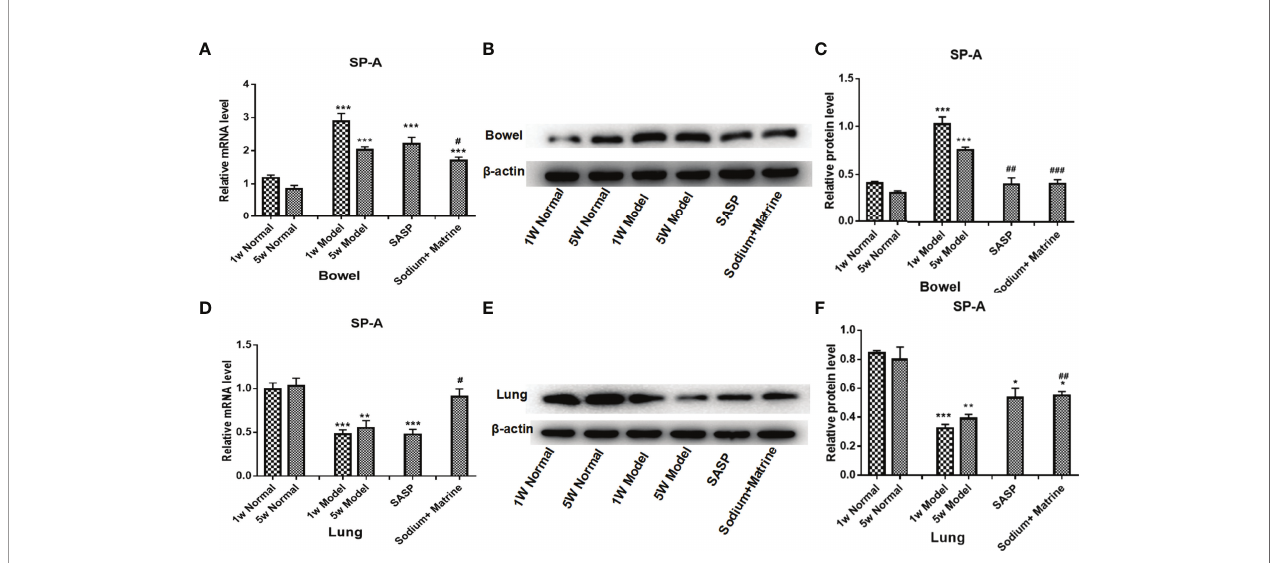
FIGURE 6 | Changes of SP-A in the lung and the bowel. UC models were established with the mucous membrane of colon allergize combine with TNBS-alcohol enteroclysis. (A) SP-A mRNA expression in the bowel (PCR); (B) SP-A protein expression in the bowel (Western Blotting); (C) SP-A relative protein level in the bowel; (D) SP-A mRNA expression in the lung (PCR); (E) SP-A protein expression in the lung (Western Blotting); (F) SP-A relative protein level in lung. Compared with Normal group, *P < 0.05; **P < 0.01; ***P < 0.001. Compared with model group, # P < 0.05, ## P < 0.01, ### P < ( Figure 7B ). After 5 w of drug administration, the blood urea nitrogen in the SASP group was signi fi cantly lower than that of the model group (P < 0.05); however, no signi fi cant difference was observed among the other groups. Negligible deviation occurred in the serum creatinine between each group (P > 0.05) ( Figure 7B ). No signi fi cant differences were found in the tissues of the liver and kidney ( Figure 7C ). In addition, we found that the feces of rats in the normal group were black, brown, or granular, without mucus, pus, and blood. The rats in the model group had a purulent and bloody stool, the stool was not formed, the color became lighter, and it was a mucinous stool or loose stool. The feces of each treatment group were mostly shaped, with a small amount of mucus stool or soft stool ( Figure 7D ).